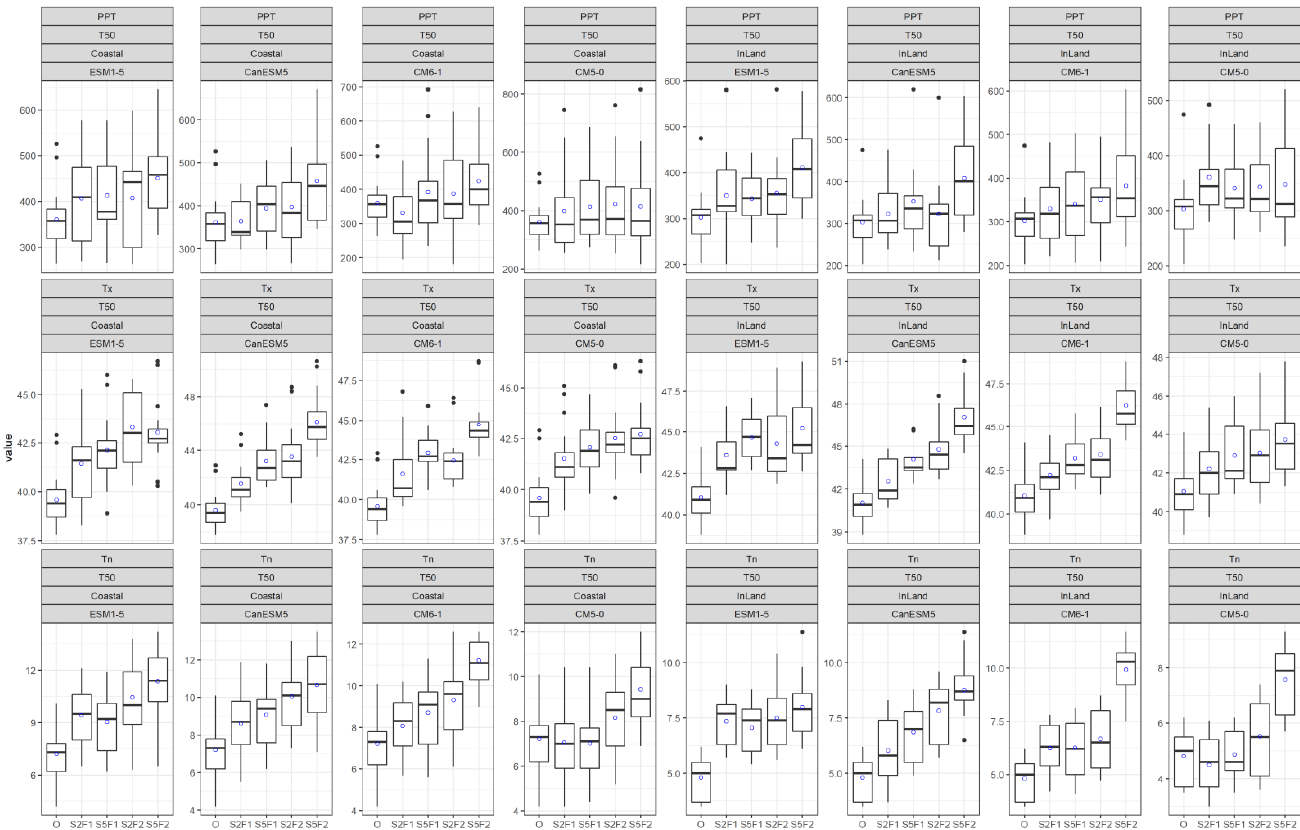
Figure 6. Box plots of 50-year return level at observed (o) and future conditions (simulations from 4 GCMs) for PPT, Tx and Tn. Future scenarios were represented by ‘S245F1’, ‘S585F1’, ‘S245F2’ and ‘S585F2’ where S245 and S585, respectively, designate SSP245 and SSP585, and F1 and F2, respectively designate future time horizon 2021–2060 and 2061–2100. The “blue circle” on each box plot represents the average value.